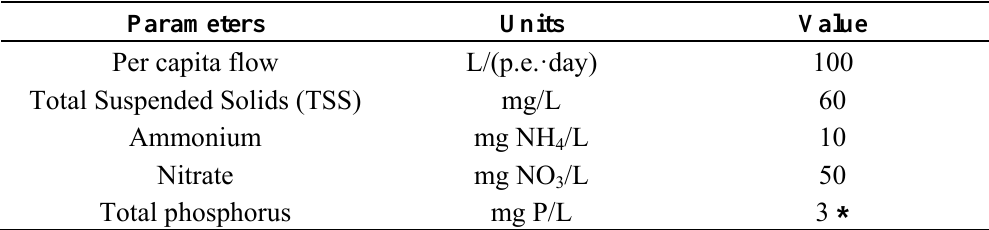
Table 3. Reference values used to characterize WWTP discharges in the SWAT model. Per capita values of flow and constituents concentrations according to the Portuguese legislation (Decreto-lei 236/98 and Decreto-lei